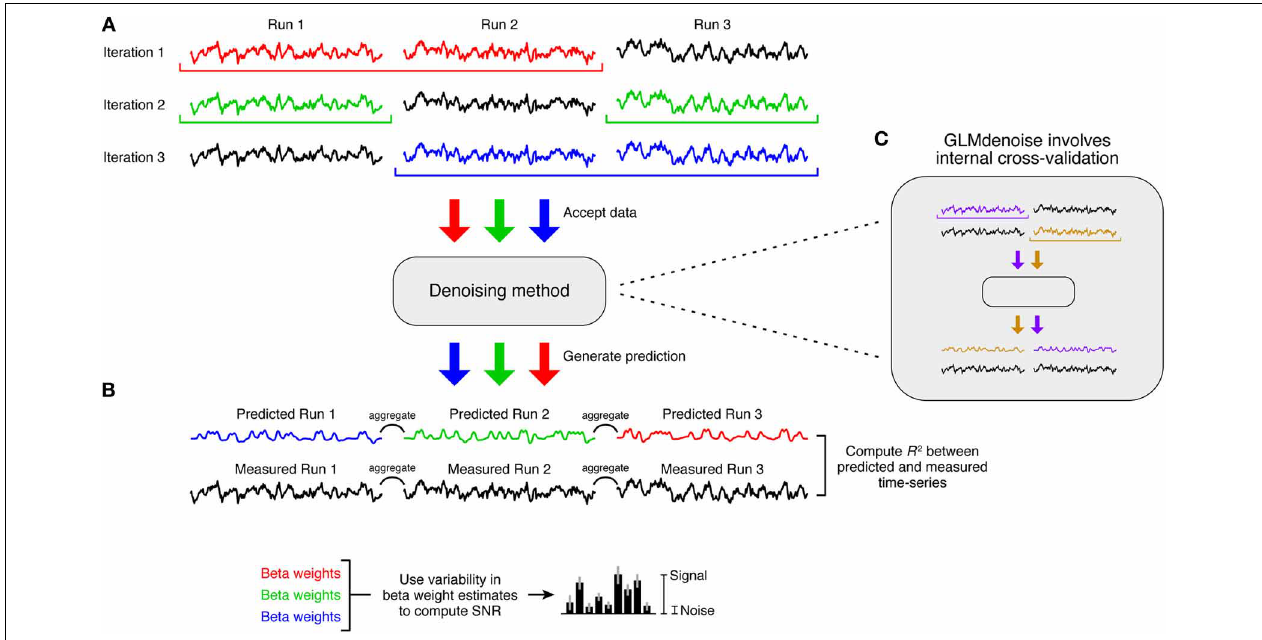
FIGURE 3 | The Denoise Benchmark (DNB). We designed an architecture that enables automatic evaluation of a candidate denoising method. (A) Cross-validation accuracy. Leave-one-run-out cross-validation is used to quantify the accuracy of the denoising method. In each iteration of this procedure, the denoising method is trained on all runs except one and is asked to predict the task-related signal in the left-out run. Predictions are aggregated across the left-out runs, and the accuracy of the predictions is quantified using coefficient of